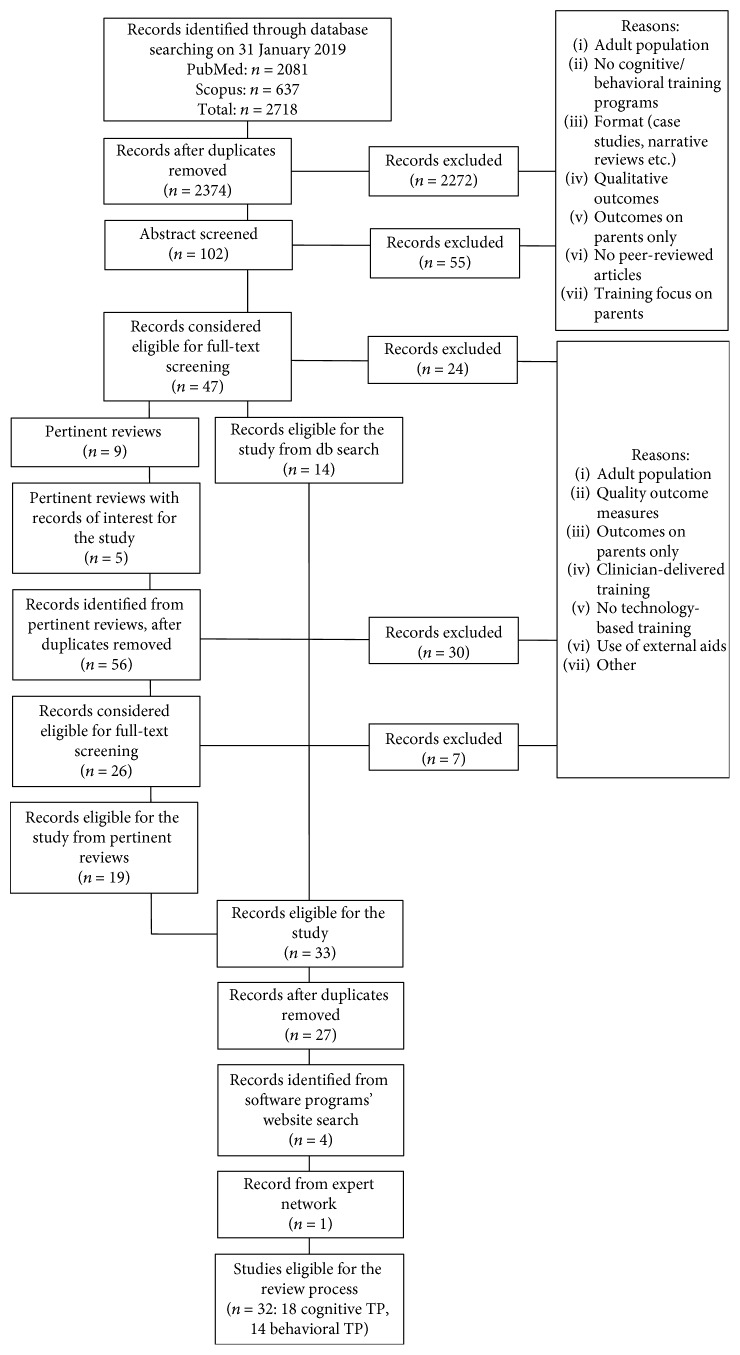
Graphical depiction of the study inclusion procedure.